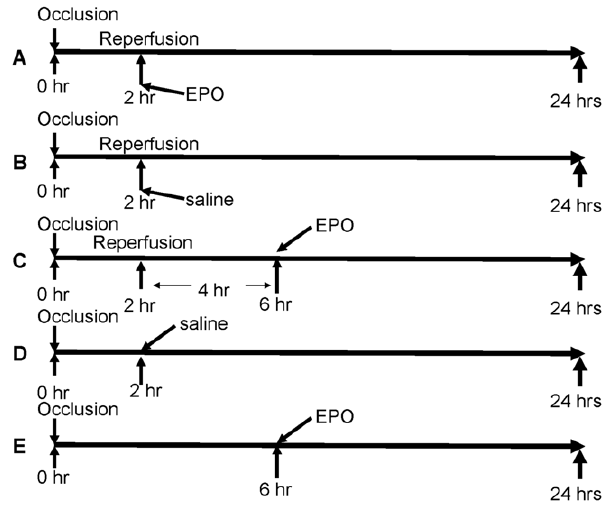
Figure 1. Diagram of experimental design. In A, B, and C left descending coronary artery is occluded for 2 hrs and reperfused for 22 hrs. In D and E left descending coronary artery is occluded for 24 hrs. rhEPO administered 2 hrs after a temporary coronary occlusion at the time of reperfusion (A), or 6 hrs after a temporary coronary occlusion, i.e., 4 hrs after beginning of reperfusion (C), or 6 hrs after a permanent coronary occlusion (E). Physiological saline administered 2 hrs after a temporary occlusion at the time or reperfusion (B) or 2 hrs after a permanent occlusion (D).